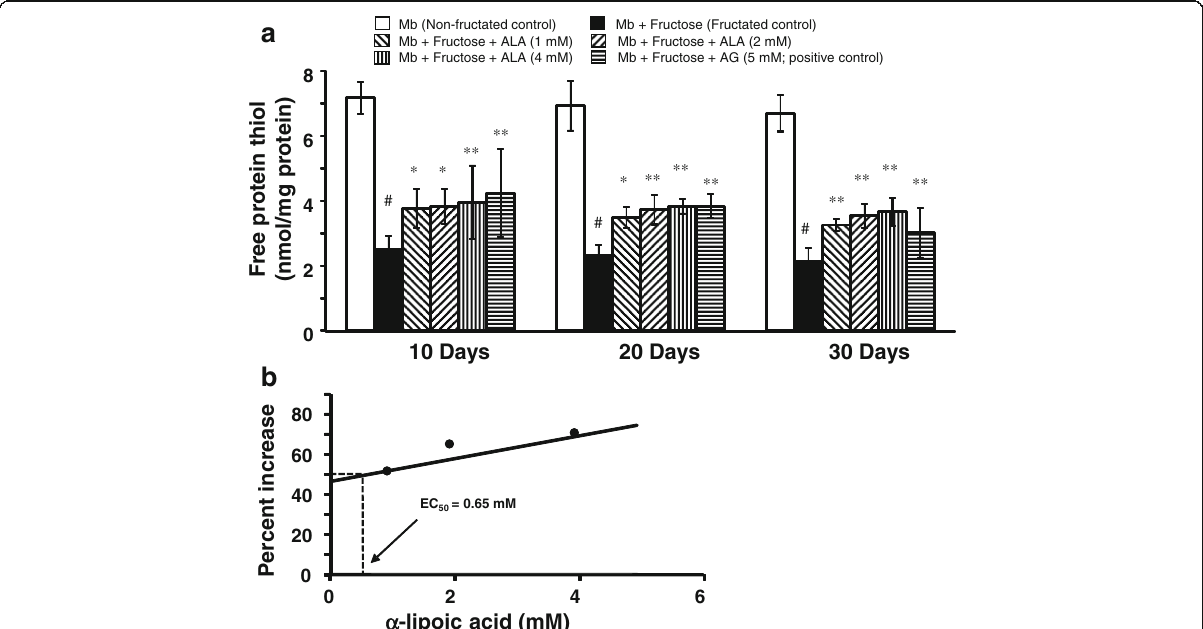
Fig. 5 Effect of α -lipoic acid on protein thiol oxidation group in fructose-induced myoglobin fructation. Each bar represents the mean ± SEM in six separate experiments (n = 6). Significant difference compared to fructated control at identical times: * p < 0.05; ** p < 0.01. Significant difference from non-fructated control: # p < 0.001. ALA = α -lipoic acid; AG = Aminoguanidine; Mb =